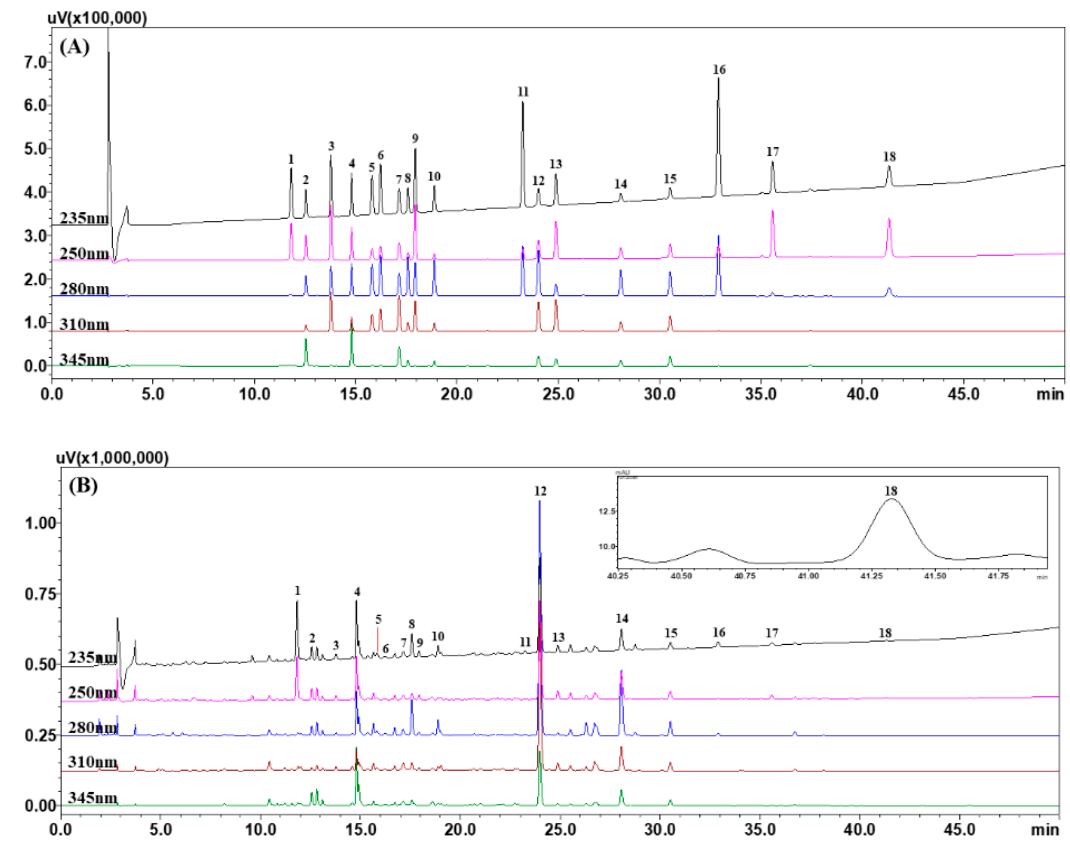
Figure 1. HPLC chromatograms of the standard solution ( A ) and test solution for quantification of 70% methanol extract of Cheongsangbangpung-tang (CSBPT) sample ( B ). Geniposide ( 1 ), coptisine Cl ( 2 ), prim - O -glucosylcimifugin ( 3 ), berberine Cl ( 4 ), liquiritin apioside ( 5 ), liquiritin ( 6 ), ferulic acid ( 7 ), narirutin ( 8 ), 5- O -methylvisammioside ( 9 ), hesperidin ( 10 ), arctigenin ( 11 ), baicalin ( 12 ), oxypeucedanin hydrate ( 13 ), wogonoside ( 14 ), baicalein ( 15 ), arctiin ( 16 ), glycyrrhizin ( 17 ), and pulegone ( 18 ).